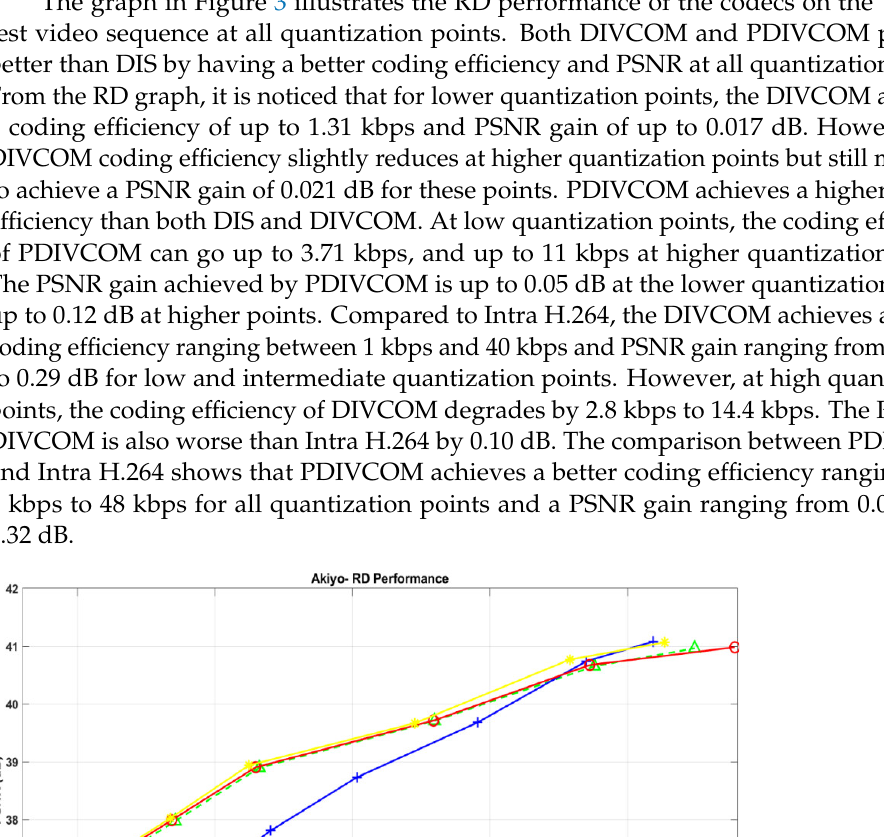
Table 6. Visual quality and rate performance evaluation of different codecs for “Foreman” video sequence at frame rate of 15 Hz.